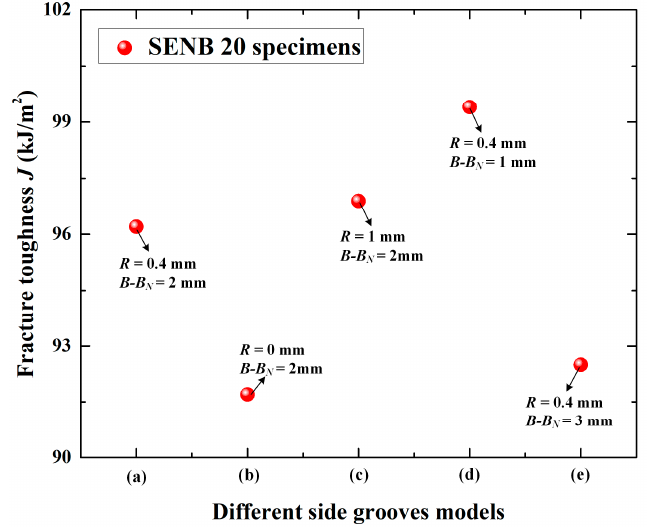
Figure 15. Fracture toughness at crack initiation of five SENB 20 models with different depth and bottom radiuses.